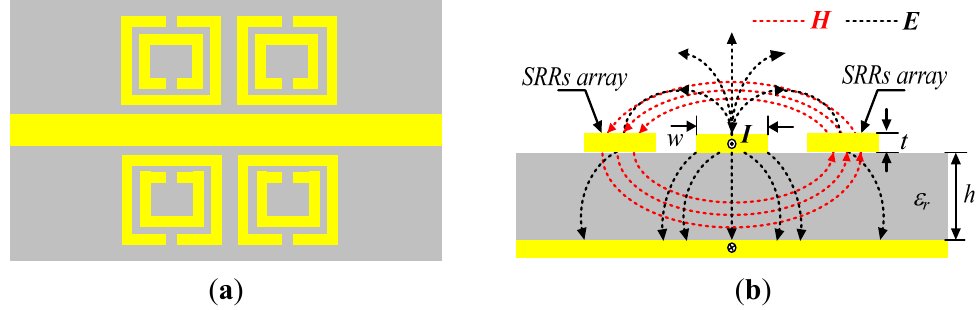
Figure 1. The structure of biosensing based on SRR array: ( a ) Top view of a microstrip transmission line and ( b ) Cross section of a microstrip transmission line with a pair SRRs and a schematic electromagnetic field distribution.